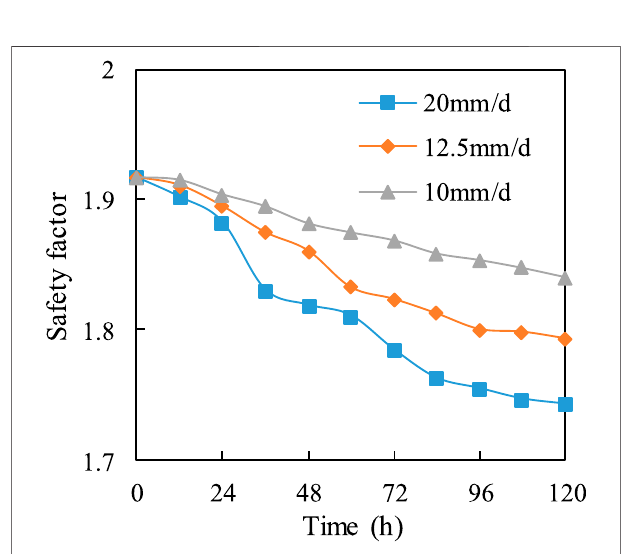
FIGURE 11 | Changes of safety factor with different rainfall